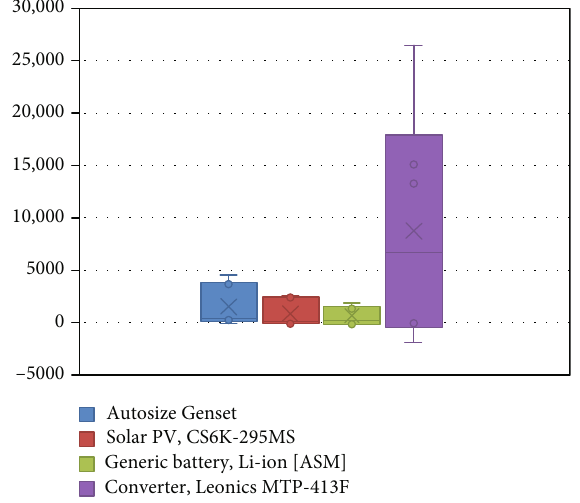
Figure 8: Cost summary (US$) from Homer Pro simulation results for PV, generator, battery, and converter.